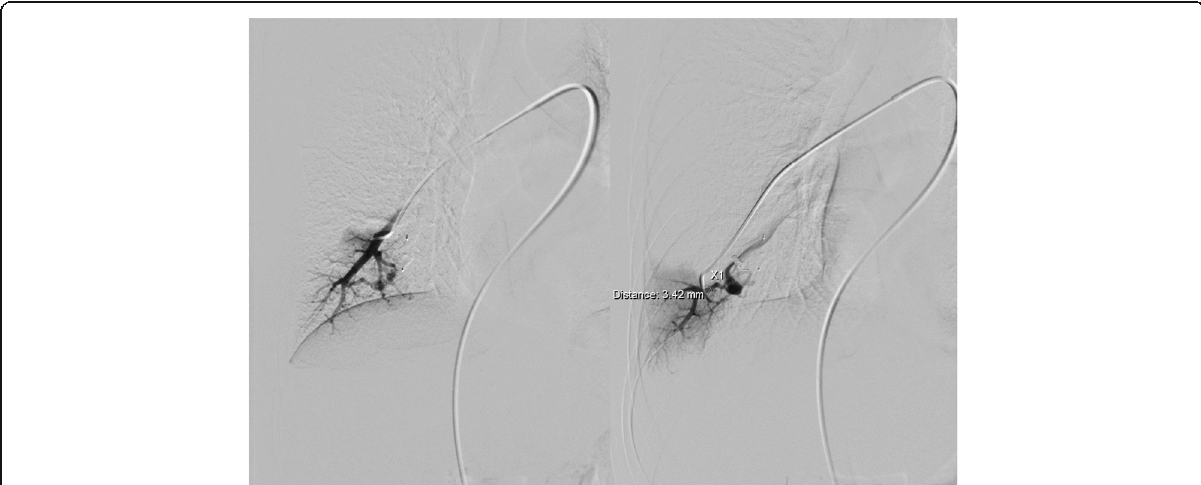
Fig. 7 Pulmonary angiography before embolization of PAVMs in the right lung with two feeding arteries